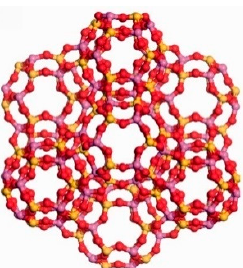
Figure 8. Schematic structure of Faujasite type zeolite. Reproduced from reference [77] under CC BY 4.0.